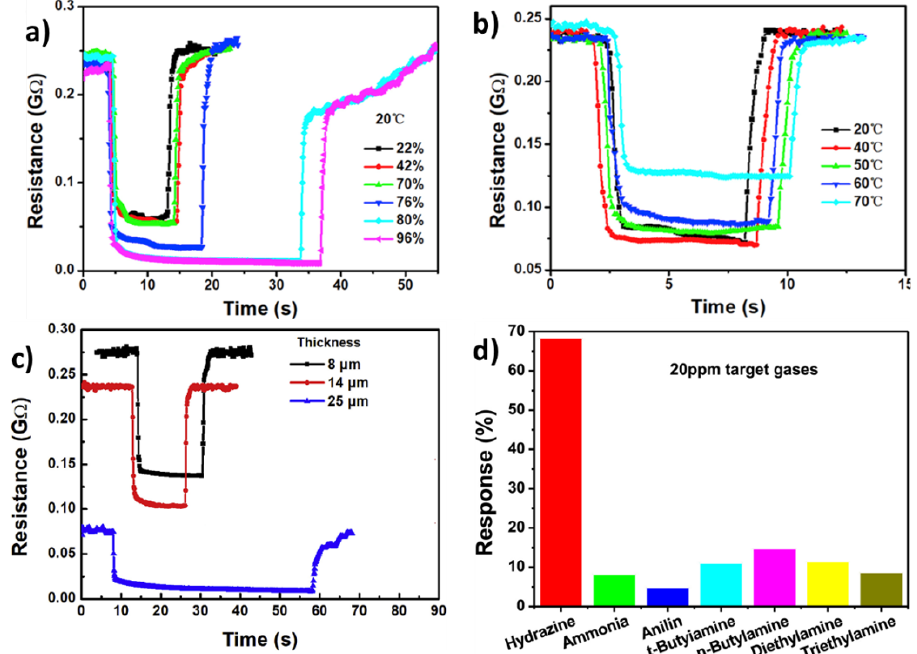
Figure 7. The effect of ( a ) relative humidity, ( b ) operating temperature, and ( c ) film thickness on the sensing properties of a PDI-pyrimidine sensor. ( d ) The response of a PDI-pyrimidine sensor towards different analytes (20 ppm). Adapted with permission